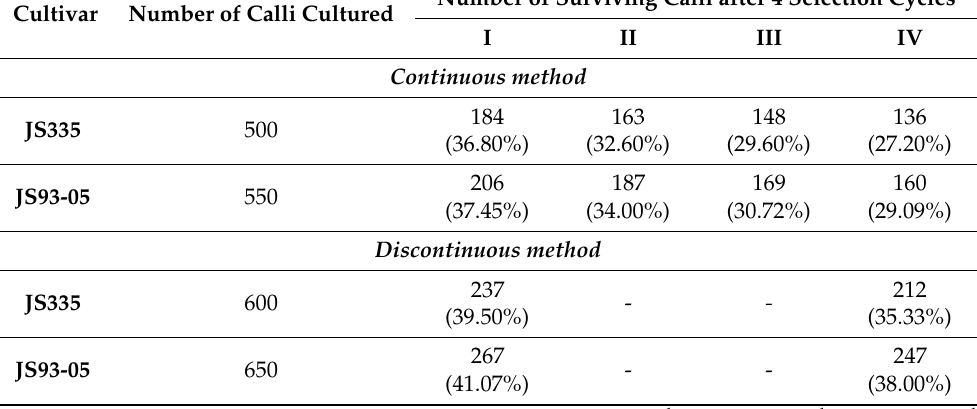
Table 4. Response of mature and immature embryonic axis and cotyledons derived calli of soybean to the lethal concentration of PEG6000.